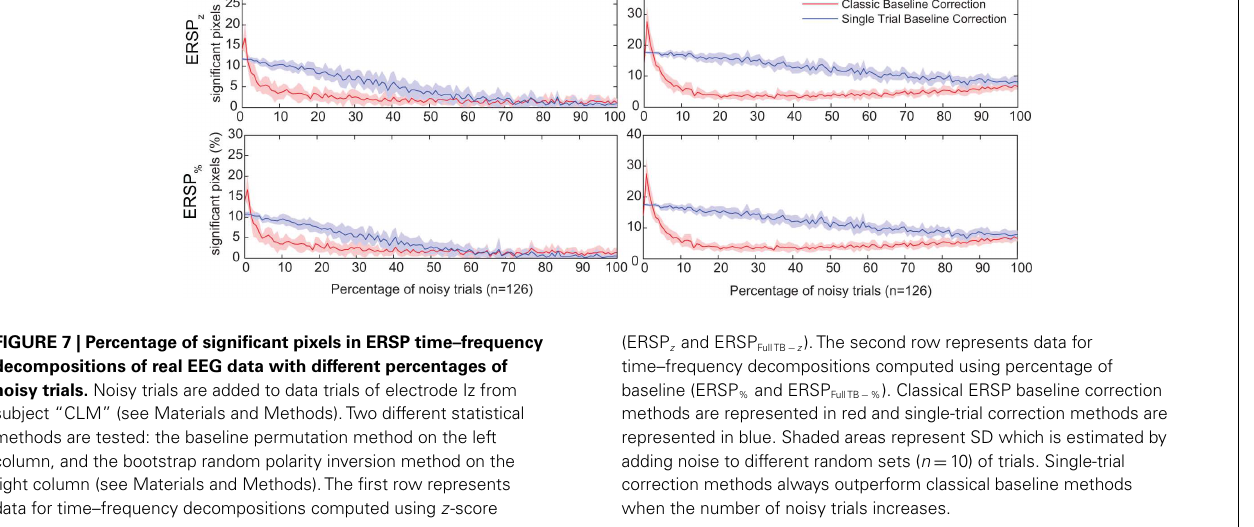
(ERSP z and ERSP FullTB − z ).The second row represents data for time–frequency decompositions computed using percentage of baseline (ERSP % and ERSP FullTB − % ). Classical ERSP baseline correction methods are represented in red and single-trial correction methods are represented in blue. Shaded areas represent SD which is estimated by adding noise to different random sets ( n = 10) of trials. Single-trial correction methods always outperform classical baseline methods when the number of noisy trials